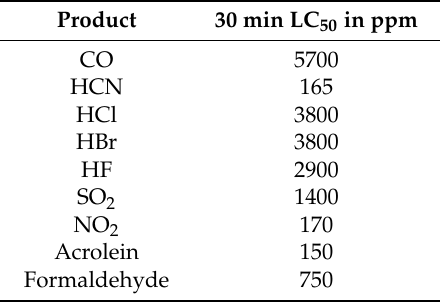
Table 1. 30 min LC 50 values for rats